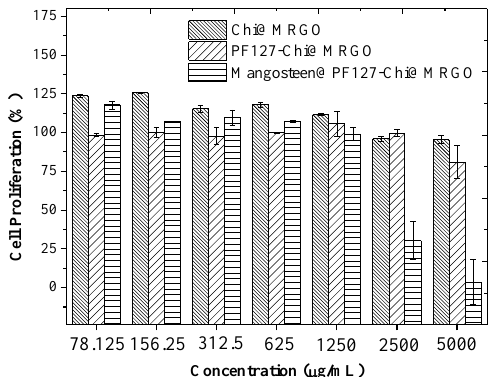
Figure 8. Cytotoxicity of Chi@MRGO, PF127- Chi@MRGO, and α -mangosteen-loaded PF127- Chi@MRGO nanocomposites against MCF-7 cell lines.